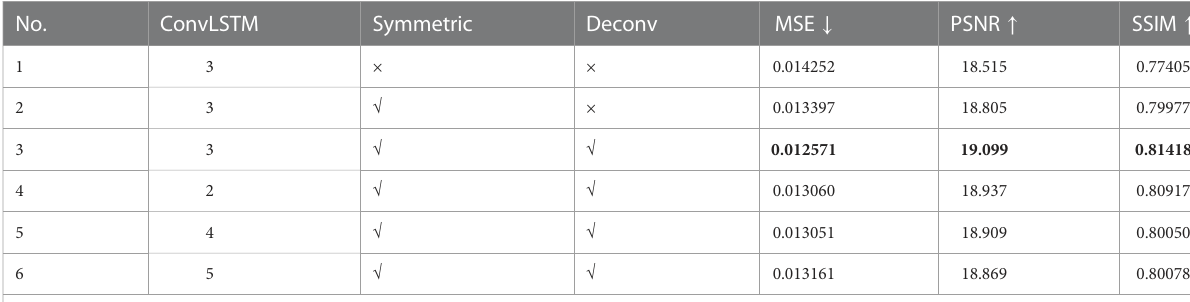
TABLE 2 Experimental results of basic model with various settings. No.